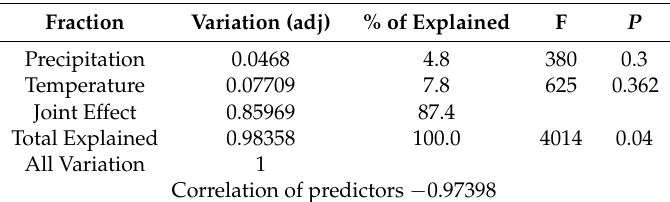
Table 6. Outcomes of RDA model(EMD) over the arid transect.